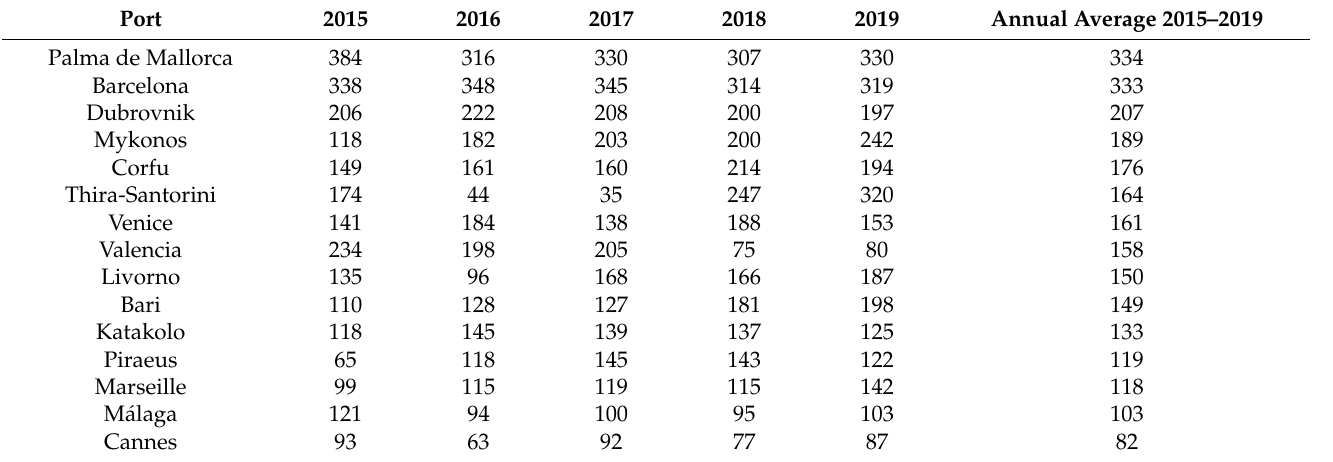
Table 5. Top 15 ports in terms of received flow and its evolution from 2015 to 2019 in the contemporary cruise port network in Southern Europe.